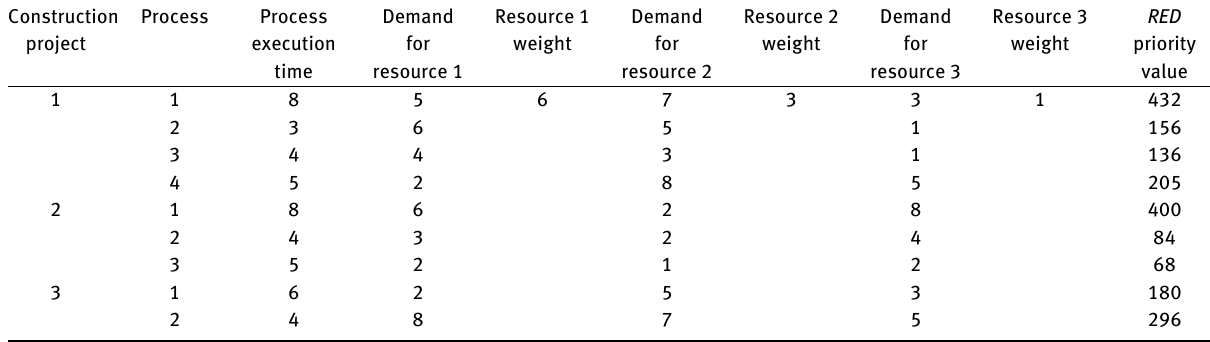
Table 3: Sample data illustrating the scheduling horizon concept. Construction